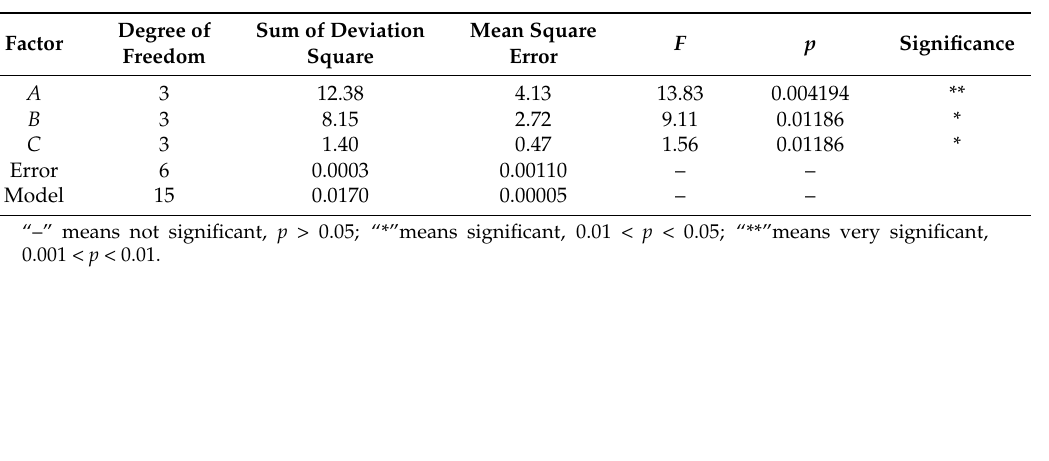
Table 6. Significance analysis for the factors affecting the tensile